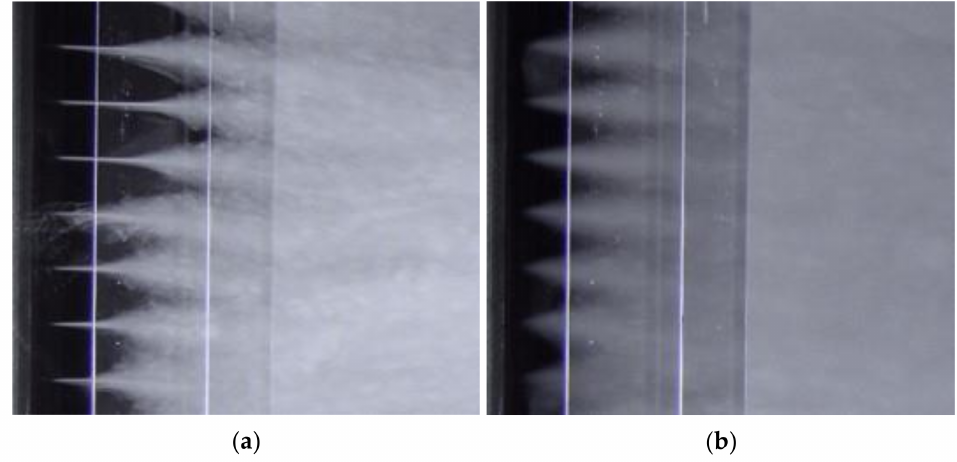
Figure 23. Oscillating jets: ( a ) jet exit velocity c 0 = 5 m/s and ( b ) jet exit velocity c 0 = 10